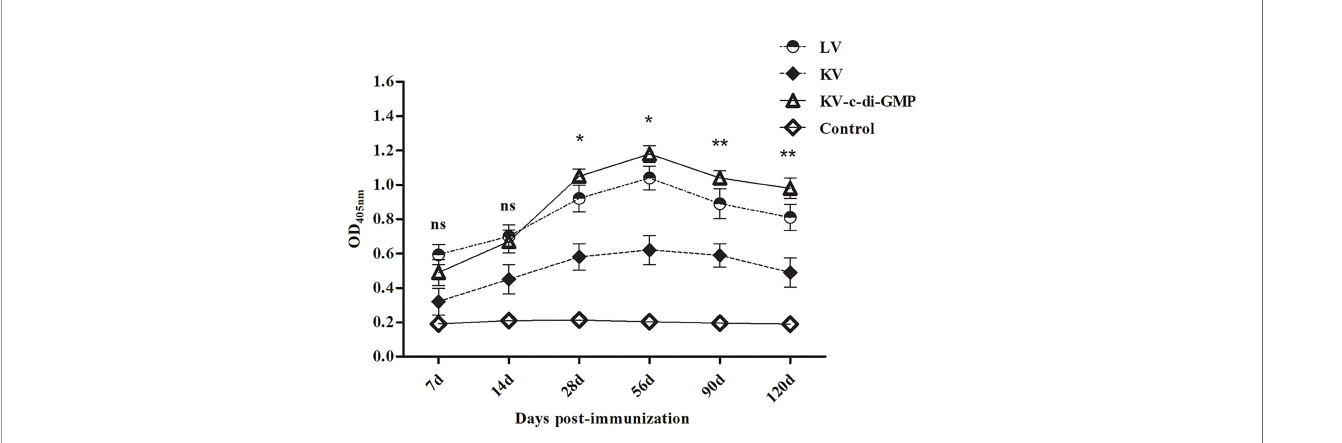
FIGURE 2 | PRV-speci fi c gB antibody responses induced by the LV, KV, and KV-C-di-GMP vaccines and PBS control in mice. Serum samples were collected at 14, 28, 56, 90, and 120 dpi. Data are expressed as the mean ± standard deviation. * P < 0.05; ** P < 0.01; ns, no signi fi cant